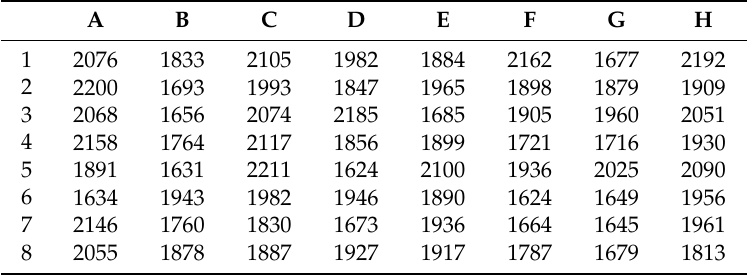
Table A11. Measured values of CO 2 concentration distribution in Experiment A4 (ppm).